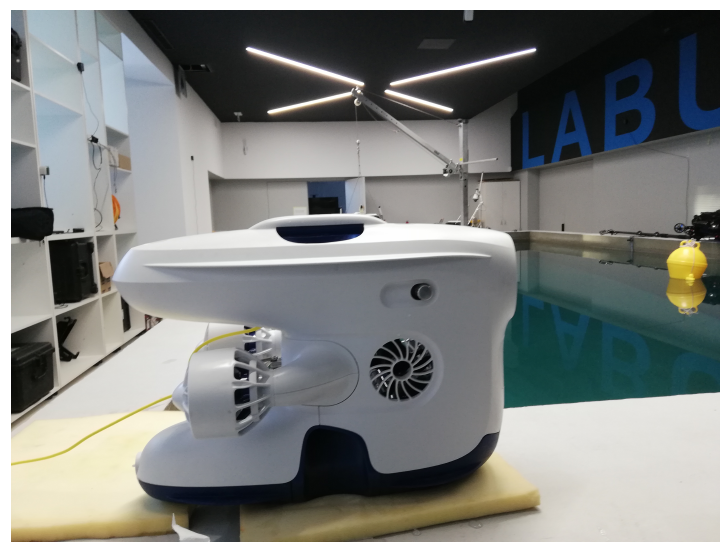
Figure 17. The Blueye Pro ROV.